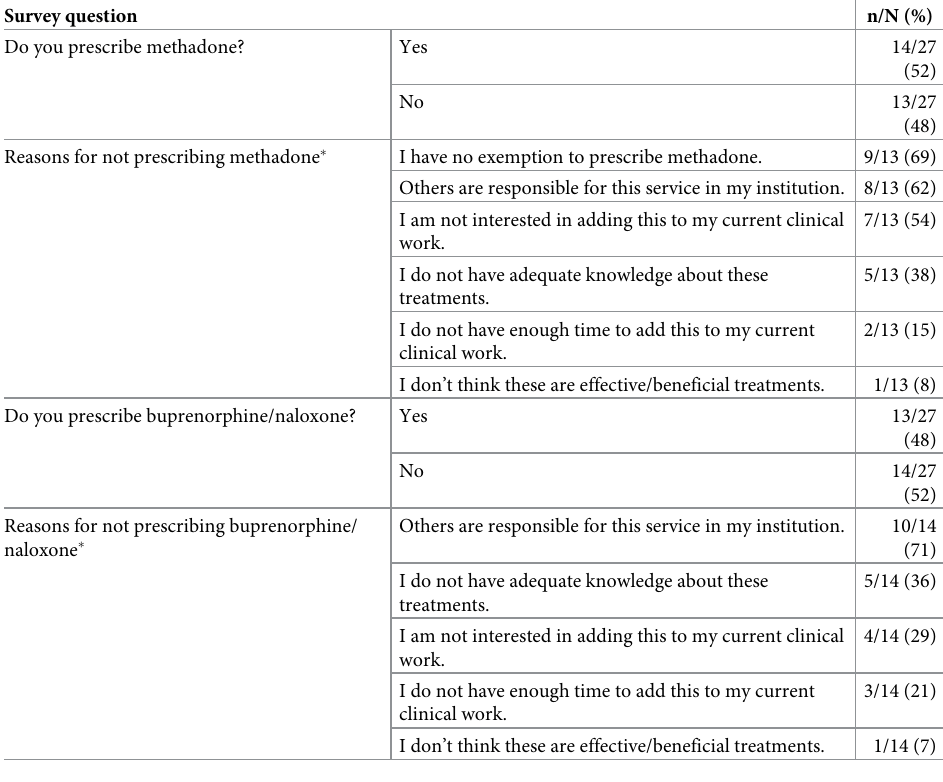
Table 1. Physician prescribing of opioid agonist treatments for opioid use disorders in provincial correctional facilities for adults in Ontario, Canada, N = 27. Survey question n/N